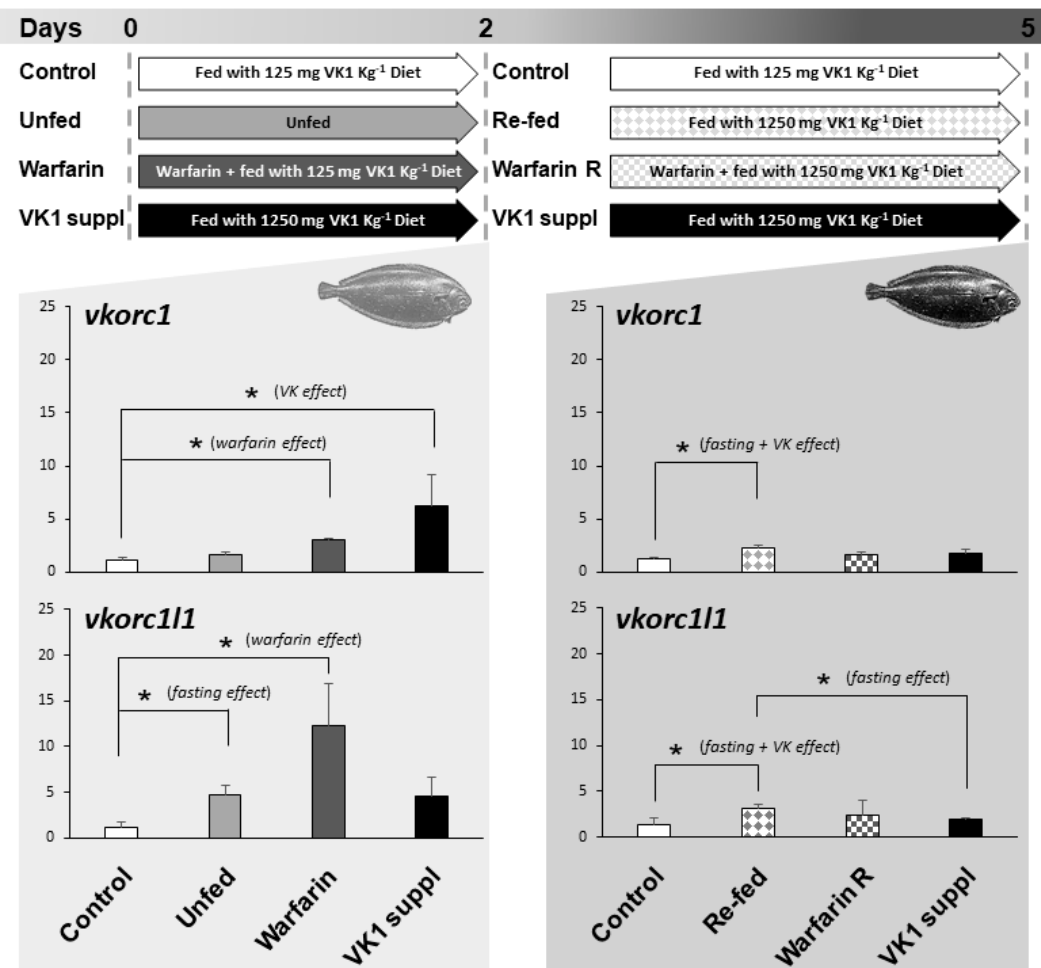
Figure 6. Experimental design and relative gene expression of Senegalese sole vitamin K epoxide reductase complex subunit 1 ( ssvkorc1 ) and vkorc1 like 1 ( ssvkorc1l1 ) in juveniles cultured under di ff erent physiological conditions. Top image: experimental design indicating the physiological conditions to which Senegalese sole juveniles were subjected, from zero to two days and from two to five days. Grey shadow graphs: mean and standard deviations values of ssvkorc1 (upper image) and ssvkorc1l1 (bottom image) transcript levels at two and five sampling days. Transcript levels were determined by qPCR and normalized using ubiquitin ( ubq ) gene expression levels. Levels in Control group were used as reference and set to 1. Left side of the graphs: juveniles fed with 125VK1 diet (Control), kept unfed (Unfed), exposed to 25 mg L − 1 of warfarin while fed with 125VK1 diet (Warfarin), or fed with 1250VK1 diet (VK1 suppl) for two days. Right side of the graphs: juveniles fed with 125VK1 diet for five days (Control), fed with 1250VK1 diet for three days after being kept unfed for two days (Re-fed), fed with 1250VK1 diet for three days while being exposed to 25 mg L − 1 of warfarin (Warfarin R), or fed with 1250VK1 diet (VK1 suppl) for five days of experiment. At two days all Experimental groups were compared to Control group, while at five days all experimental groups were compared to Control and VK1 suppl group. Asterisks on the top denote significant di ff erences between the two experimental groups compared (n = 3; Student’s t-test; P < 0.05). Text in brackets indicates the e ff ect studied within each comparison.